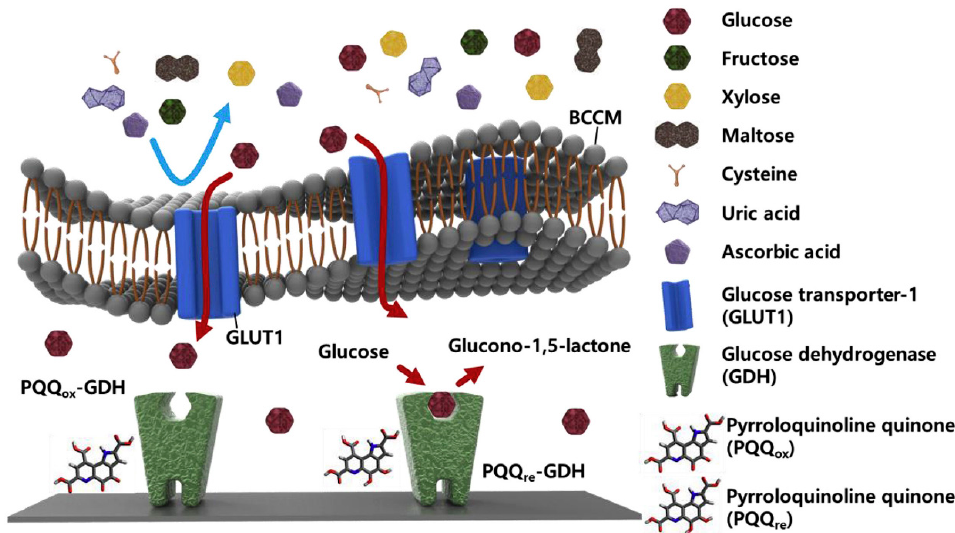
Figure 8. Schematic representation of enzymatic glucose sensor coated with breast cancer cell mem- brane (BCCM). The BCCM acts as a diffusion barrier to impede the transport of large and uncharged molecules (fructose, xylose, and maltose) and ions (cysteine, uric acid, and ascorbic acid), whereas it facilitates the active transport of glucose via glucose transporter-1 (GLUT-1). Glucose dehydrogenase (GDH) then reacts with glucose without any interference. [reproduced with permission from Kim, Kwon, Lee, Lee, and Yoon [104], copyright 2019 Elsevier].